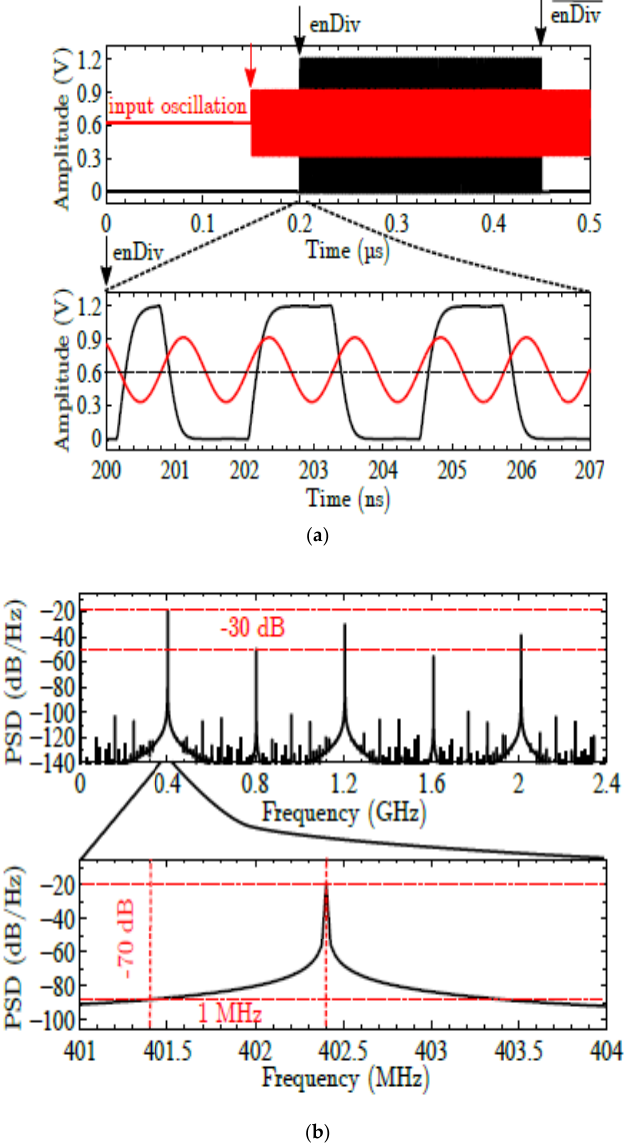
Figure 6. ( a ) Simulated time response of the frequency divider, ( b ) Power spectral density (PSD). plot of the combination of divider and Colpitts oscillator (N = 2 20 resolution bandwidth 25.1 kHz).